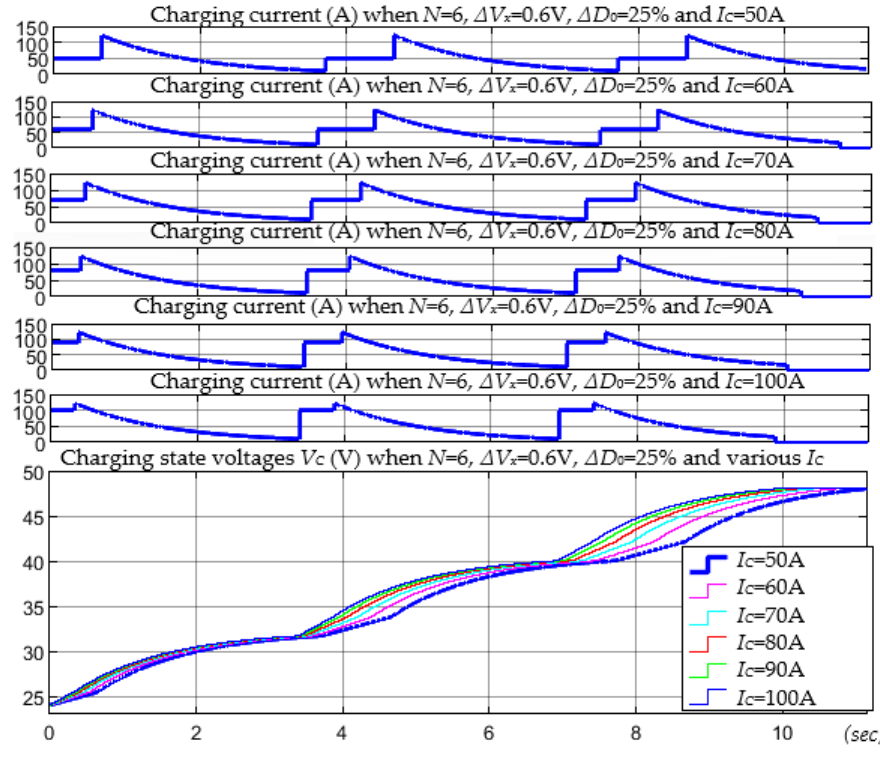
Figure 30. SC circuit charging current and voltage diagrams with ∆ V x = 0.6 V, ∆ D 0 = 5% at different constant currents.